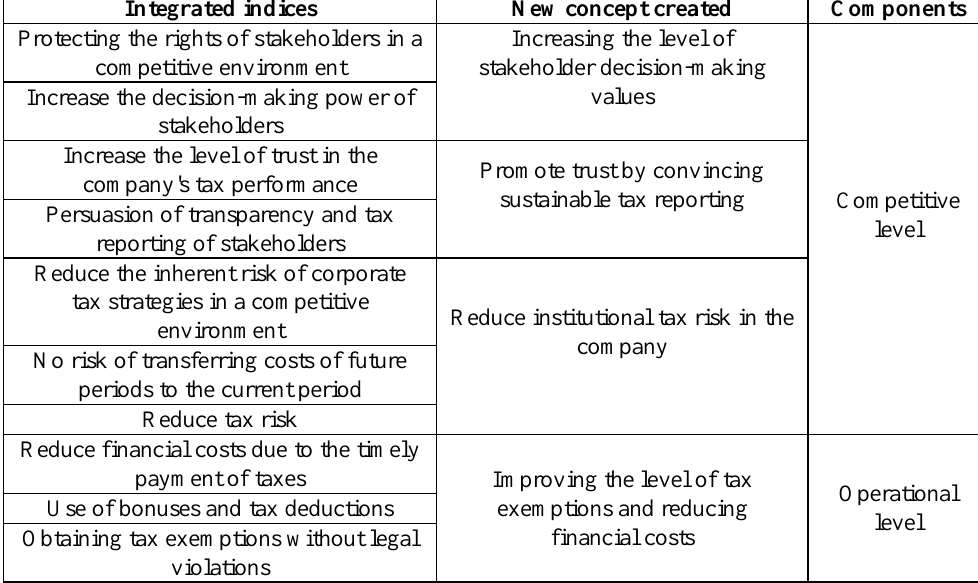
Table 5. First-round Delphi's integrated indices